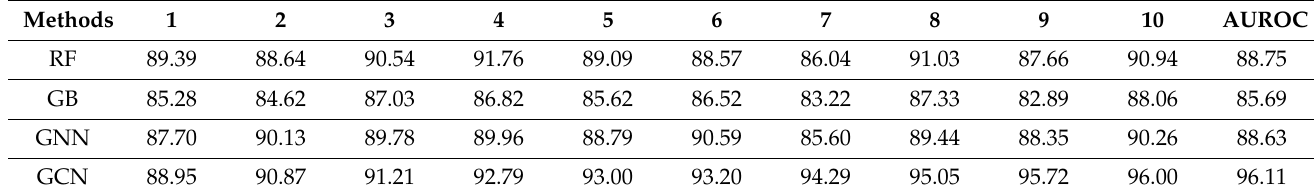
Table 2. Ten-fold cross validation accuracies for link prediction using RF, Gboost, and GNN in GDKG.